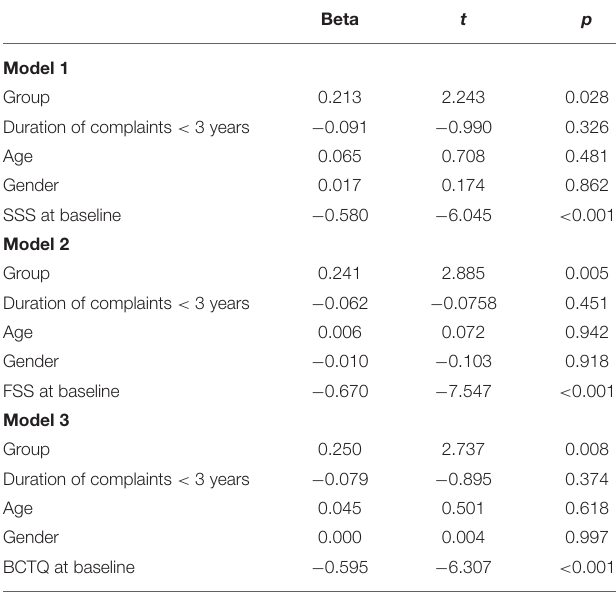
TABLE 3 | Results of the multiple linear regression analysis predicting change in SSS (model 1), FSS (model 2), and BCTQ (model 3)